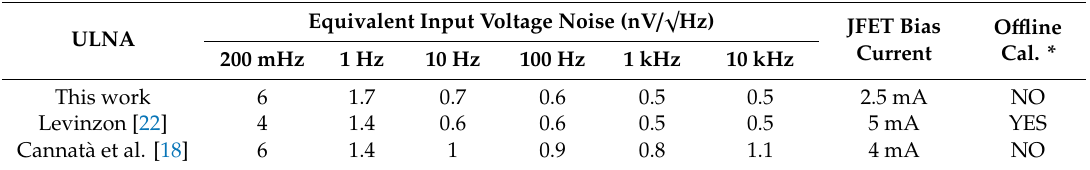
Table 2. Comparison of the prototype in this work with other works.